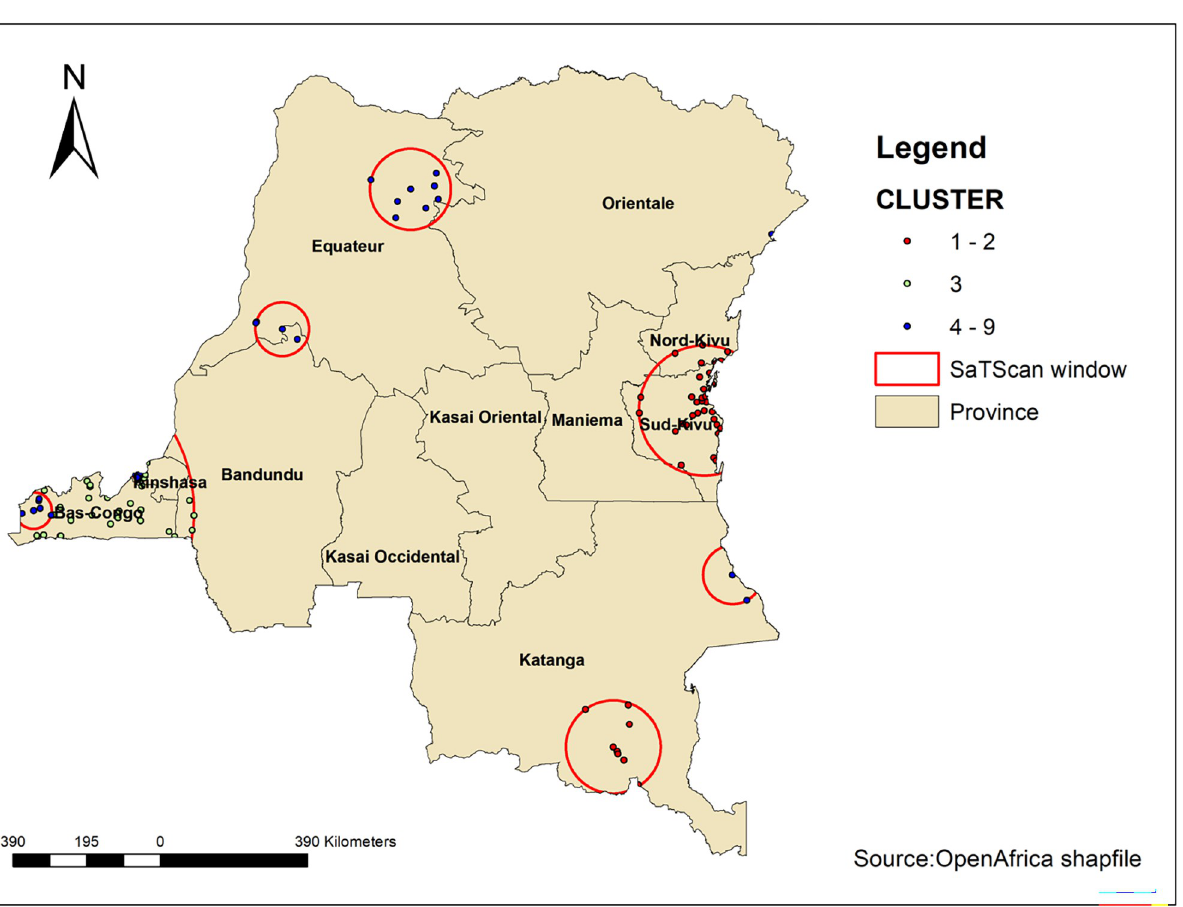
Fig 8. SaTScan analyses of high-risk fertility behaviours among married women in the Democratic Republic of the Congo.